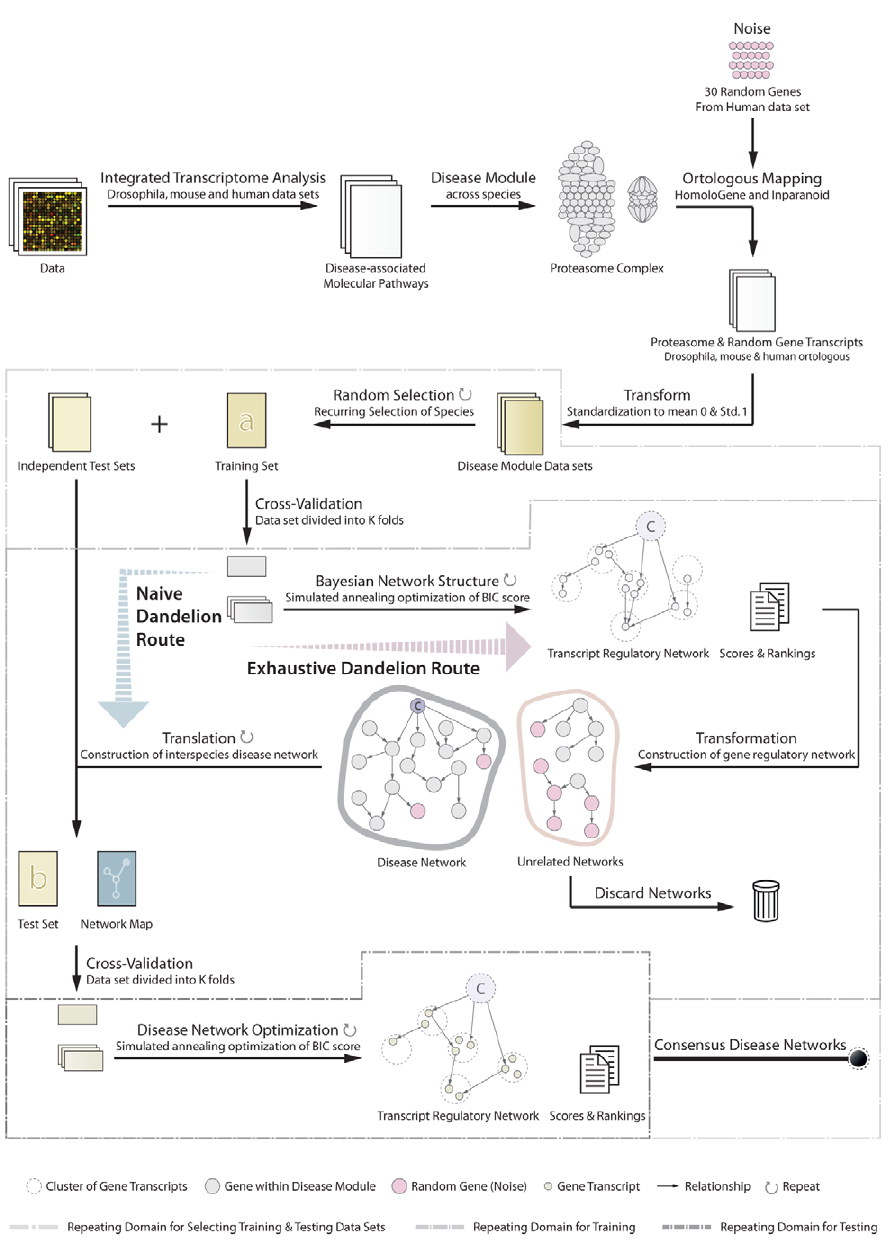
Figure 1. Schematic overview of the Dandelion algorithm for disease network analysis. The Dandelion algorithm involves three recurring stages of training and independent testing regime with the use of multiple datasets derived from different species. In the first step, disease modules are defined as the most consistently disease-associated molecular pathway across species. The disease module is supplemented by a set of randomly selected genes to assess the performance of the algorithm and to check for overfitting. These datasets are standardized to mean 0 and standard deviation of 1 across genes. The next step involves reiterative selection of one species as an organism in which the gene regulatory network is constructed while others are left aside for independent testing and validation of learnt disease networks. For an intraspecies construction of disease network, dataset is divided into k-folds, using cross-validation, and regulatory relationships between gene transcripts are learnt using Bayesian network methodology enhanced by simulated annealing optimization of network BIC score. After applying confidence thresholds on relationship between genes, the disease network can then be translated to the expected interspecies disease network which we call a network map. Using the cross-validation and network optimization procedure the algorithm searches through the relationships found in the training dataset to find the best fit for interspecies representation of the disease network. These networks are then integrated by removing all the links with low confidence score across species. constructed intraspecies networks are already at the gene level. Dandelion algorithm, a detailed interaction map of a candidate Using the cross-validation and network optimization procedure, the intraspecies disease network of gene transcripts needs to be algorithm searches through the relationships present in the network transformed to a network map of gene-gene relationships. This map (constructed on the training set) to find the best fit for the step can be omitted in the naı¨ve Dandelion algorithm as the